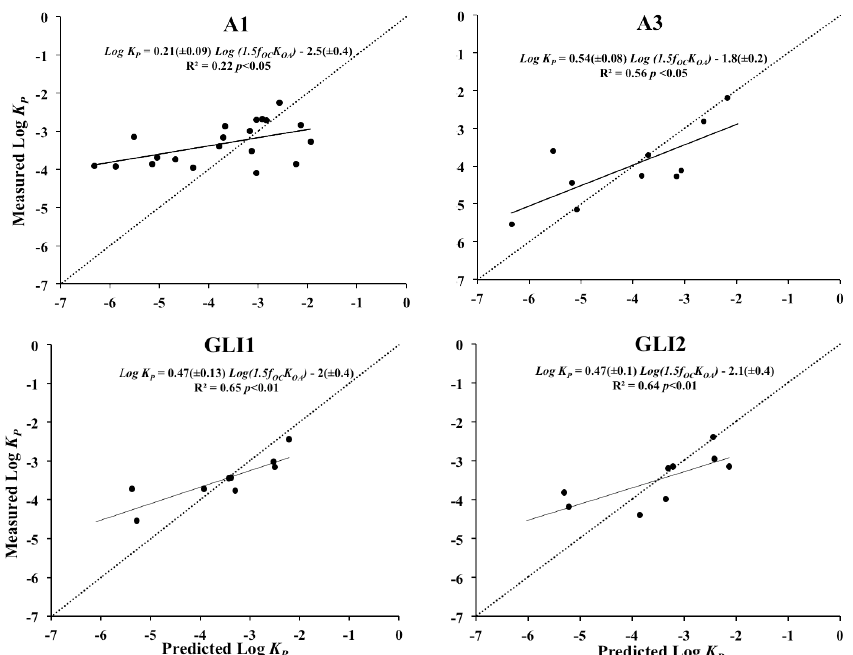
Fig. 3. Gas-particle partition of PCBs. Measured versus predicted particle-gas partition coefficients (Log K P ) estimated for samples taken over the Southern Ocean (samples A1 and A3 in upper panels) and at Livingston island (samples GLI1 and GLI2 in lower panels).